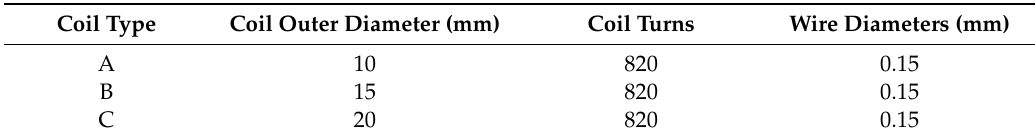
Table 3. The primary coil parameters.